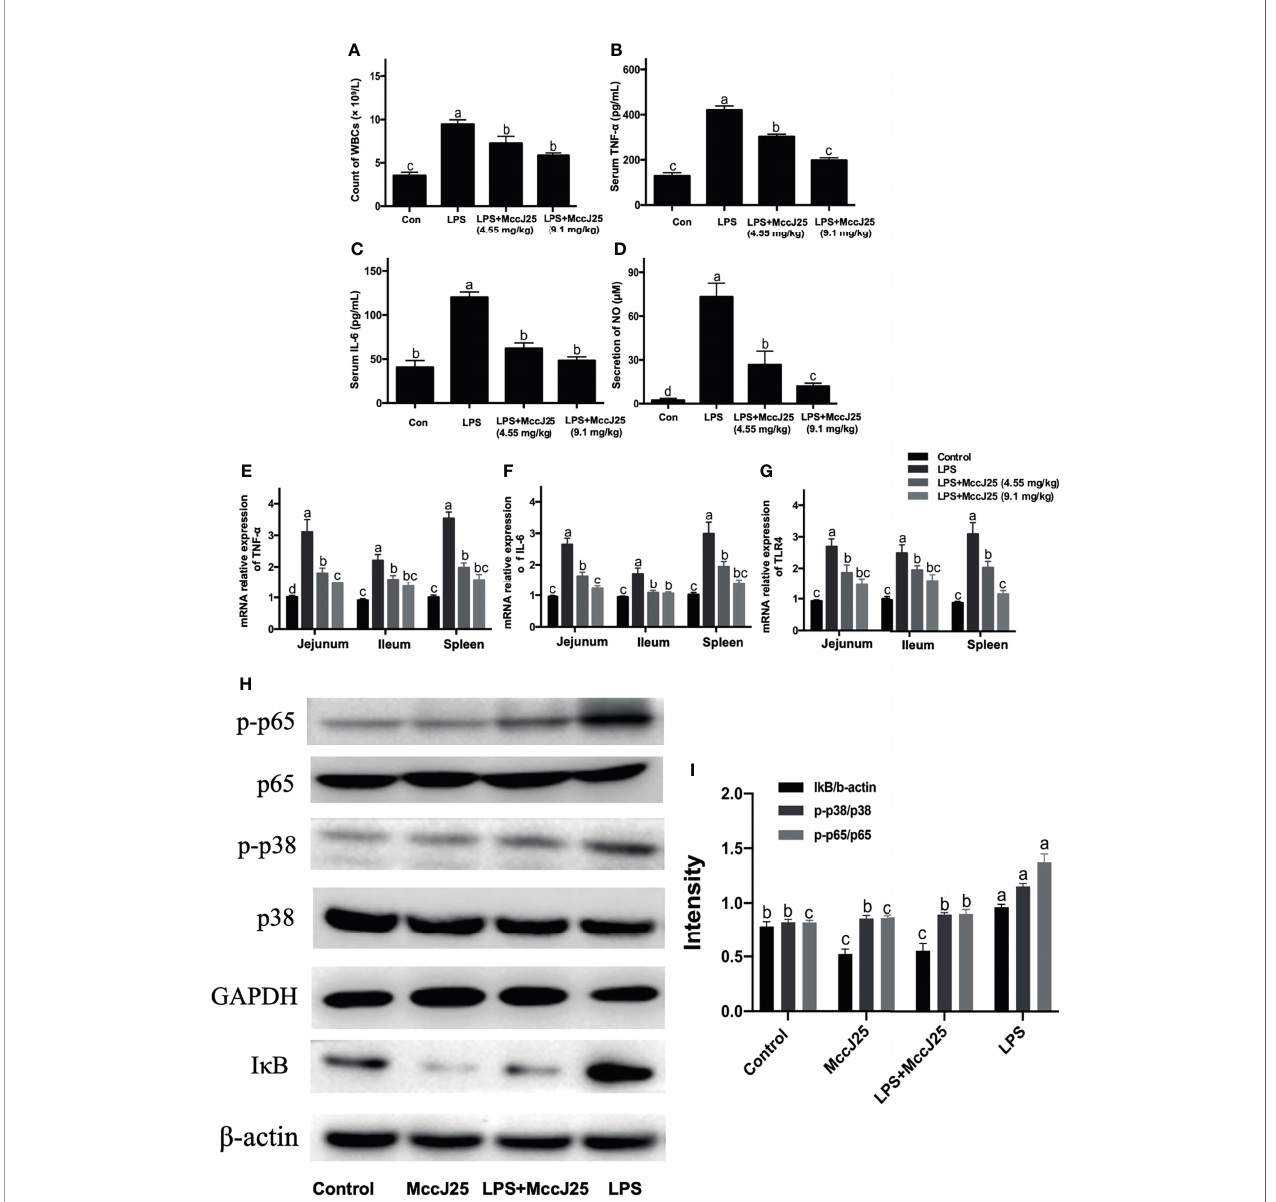
FIGURE 7 | MccJ25 effectively inhibits gut in fl ammation in LPS-induced mice. (A-G) Antimicrobial peptide MccJ25 decreased serum WBC counts (A) , TNF- a (B) , IL-6 (C) secretion, and NO production (D) . (E-G) AMP MccJ25 inhibited TNF- a (E) , IL-6 (F) , and TLR4 (G) mRNA expression in the jejunum, ileum and spleen. (H, I) MccJ25 possesses an inhibitory function on the NF- k B and MAPK signaling pathways in mice. (H) Representative picture of phosphorylated protein levels of NF- k B and p38 MAPK. (I) Protein expression of phosphorylated NF- k B and p38 MAPK. Data are expressed as the mean ± standard error of mean of 6 sample replicates. Different superscript lowercase letters within each group indicate signi fi cant differences between them ( P <